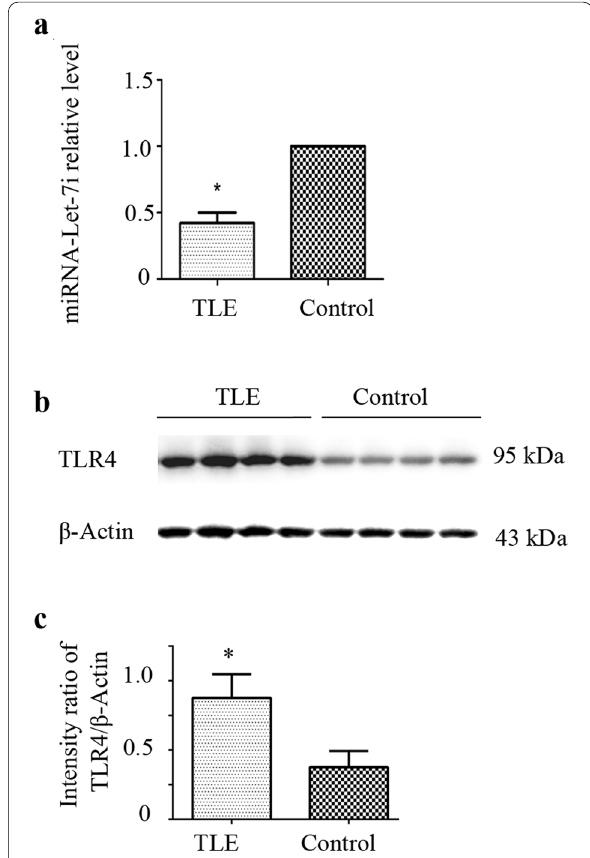
Fig. 6 Evaluation of miRNA-Let-7i expression and TLR4 protein level in TLE patients. a The expression of miRNA-Let-7i was significantly decreased in the brain tissues of TLE patients compared with that in the control patients. b Representative Western blots of TLR4 in the brain tissues of TLE patients and controls. c Quantification of ( b ) showed that the protein level of TLR4 was significantly increased in TLE patients compared with controls (* P < 0.05 versus control group; n 10 in TLE group and n 10 in control = =